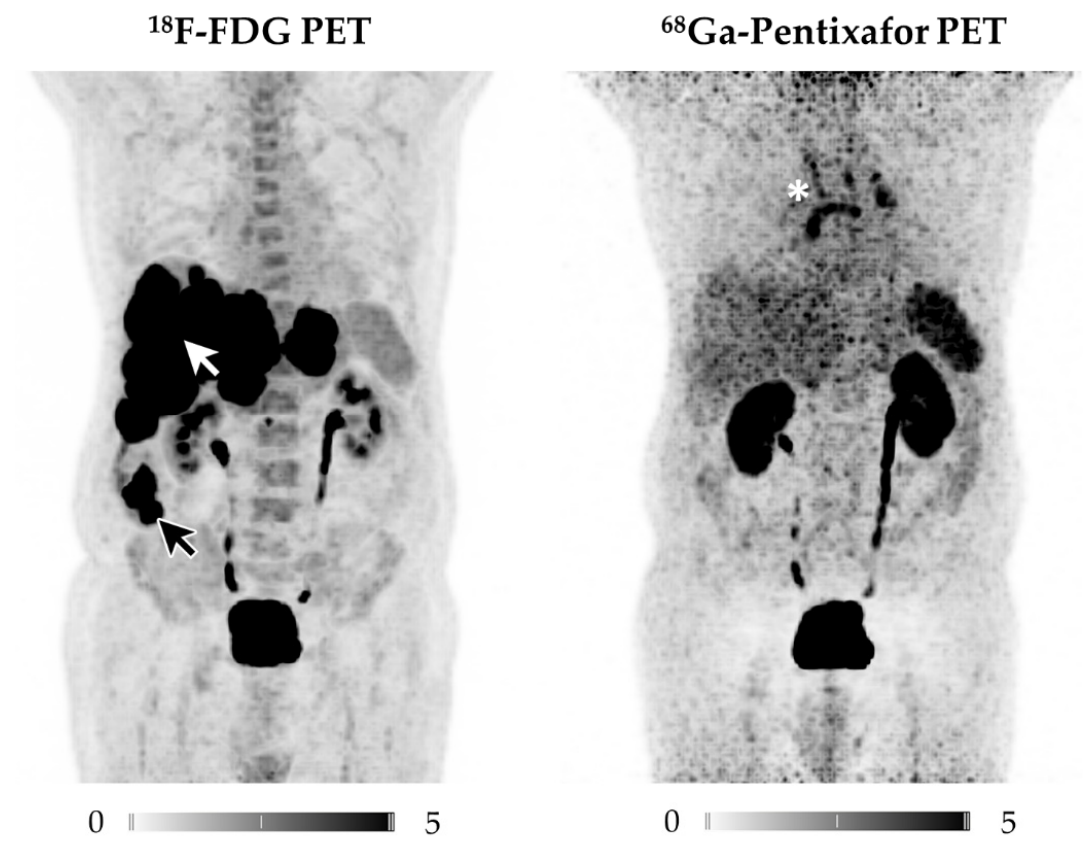
Figure 1. Displayed are Maximum Intensity Projections (MIP) of the 18 F-FDG (left) and 68 Ga-Pentixafor PET scans of patient #2. Whereas 18 F-FDG depicts the ileal primary (black arrow) as well as multiple liver metastases (white arrow), none of the tumor manifestations are revealed by CXCR4-directed PET imaging. Incidental finding: The mediastinal tracer uptake in 68 Ga-Pentixafor PET (white star) was traceable to enlarged mediastinal lymph nodes, most likely due to chronic lung fibrosis and not related to NEC, as follow-up imaging confirmed.